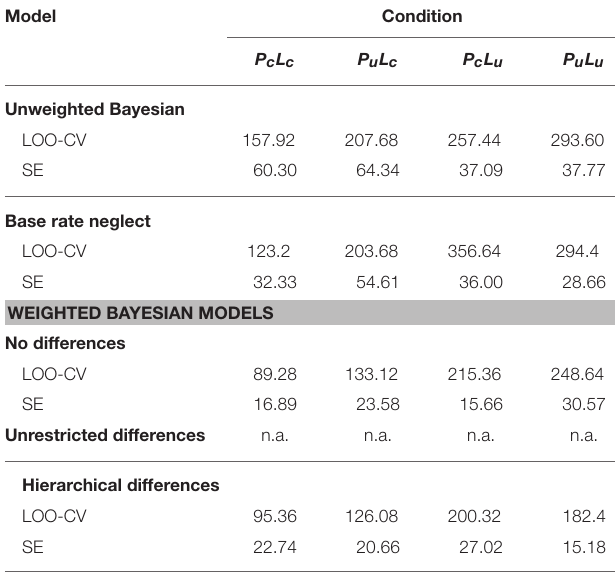
TABLE 2 | WAIC deviance measures and standard errors for experimental conditions and models. Model